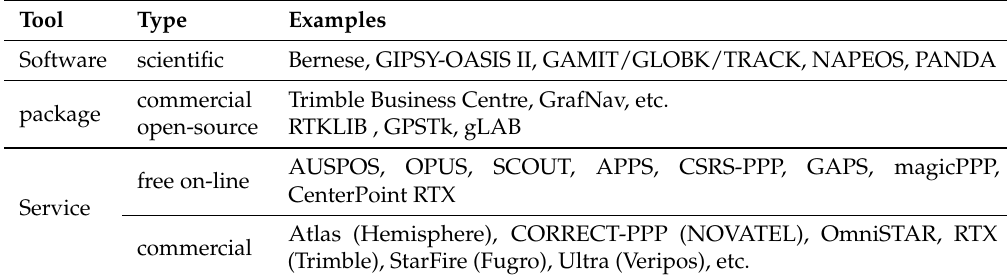
Table 1. Precise GPS observation data processing software packages and